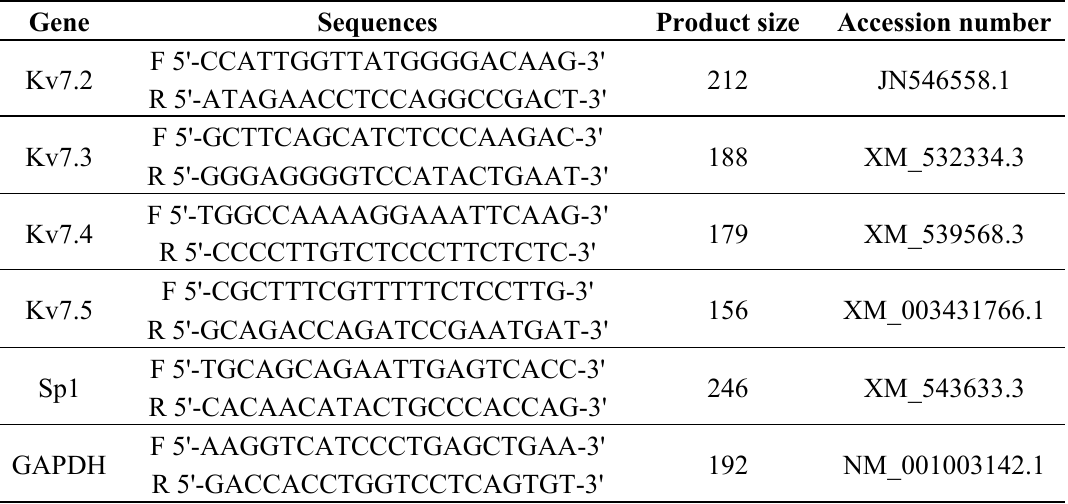
Table 1. PCR primers for RT-PCR and